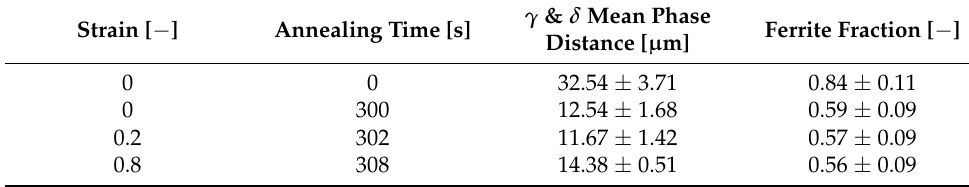
Figure 6. Microstructures before and during the compression test at 1100 ◦ C and 0.1 s − 1 with an initial ferrite volume fraction of ( a ) 84%, ( b ) 59% after 300 s pre-heating at 1100 ◦ C, ( c ) 57% after ϕ = 0.2, ( d ) 56% after ϕ = 0.8. Ferrite is depicted as grey and austenite as white. ( e ) Phase distribution before and after pre-heating of 300 s before compression test for initial ferrite volume fraction of 84%. Table 3. Microstructure parameters of the material condition of 84% initial ferrite fraction after solution annealing of 1 h at 1250 ◦ C and during forming at 1100 ◦ C and 1 s − 1 measured via optical microscopy and